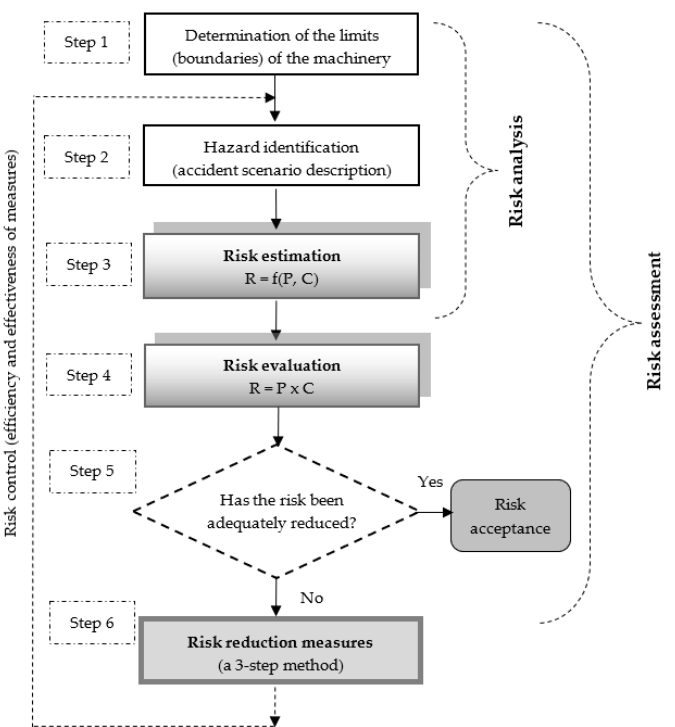
Figure 1. Simplified procedure for machinery risk assessment/risk control (inspired by ISO 12100:2010).